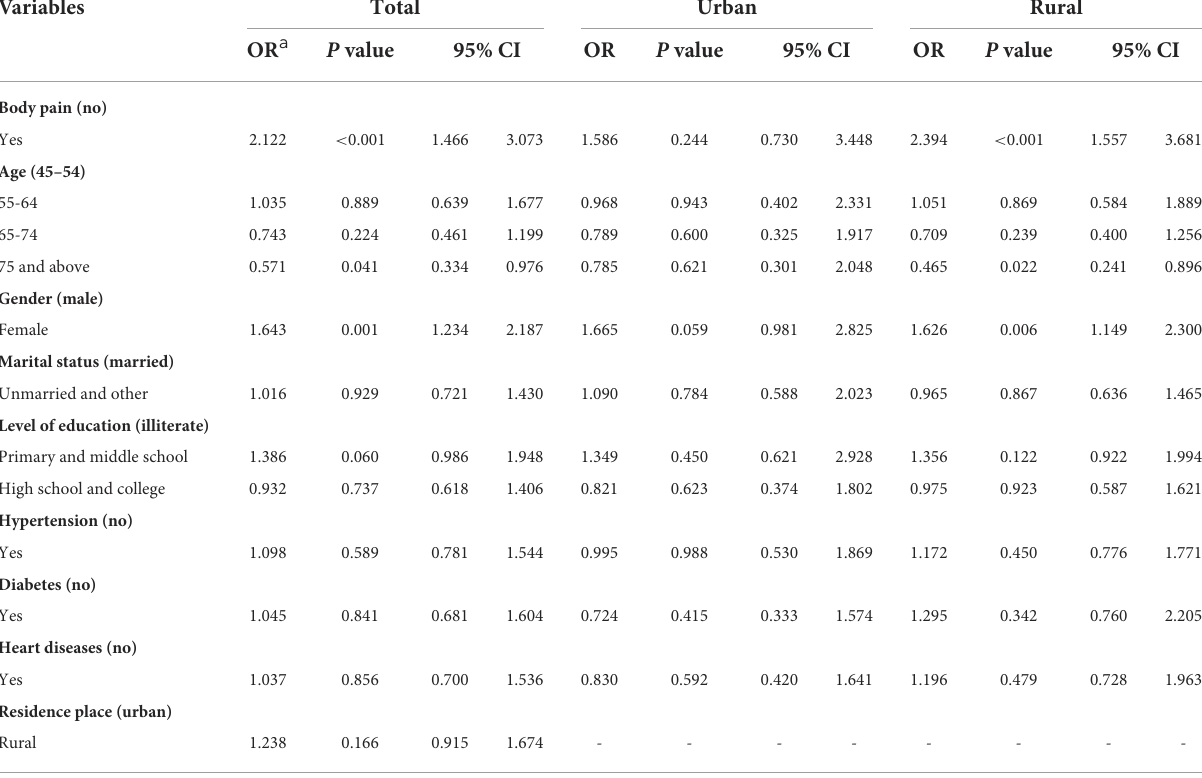
TABLE 5 Association of body pain with depression among patients with stroke.